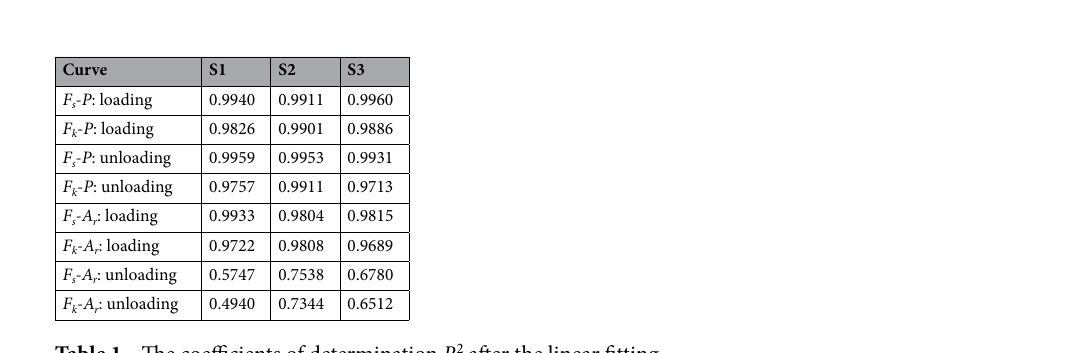
Table 1. The coefficients of determination R 2 after the linear fitting.